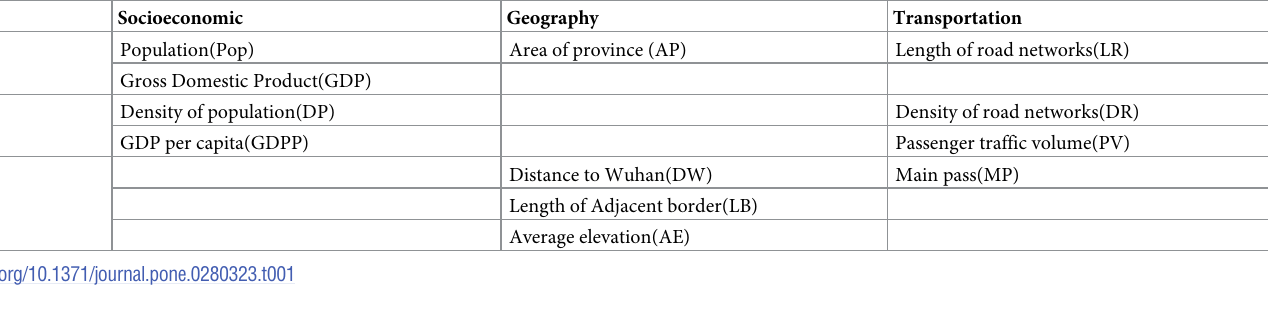
Table 1. The classification of selected 12 indicators for correlation analysis. Socioeconomic Geography